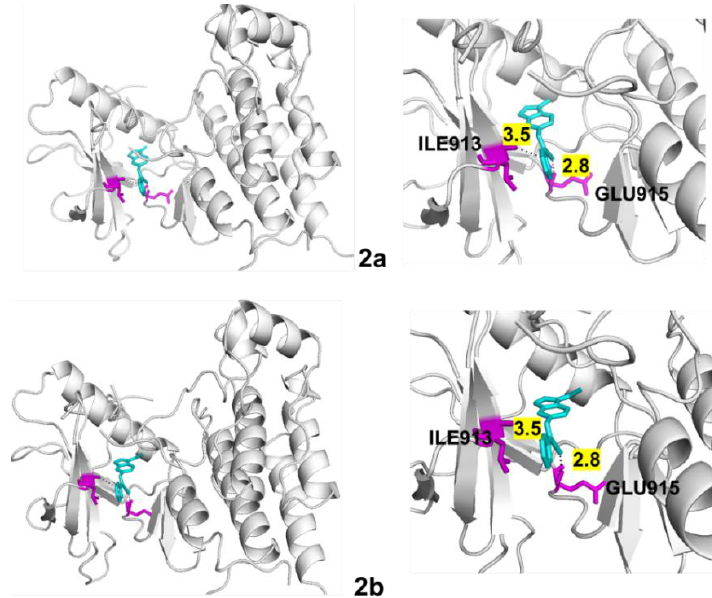
Figure 12. Molecular docking of 2a and 2b into VEGFR-2. Table 3. Binding energies (B.E.) and H bond information for 2a and 2b when docked into EGFR and VEGFR-2.